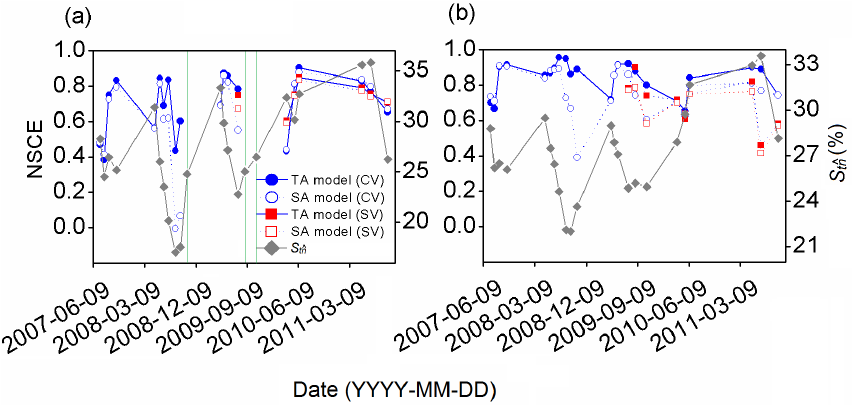
Figure 8. The Nash–Sutcliffe coefficient of efficiency (NSCE) of soil water content estimation using the TA and SA models for (a) 0–0.2 and (b) 0–1.0m for both cross-validation (CV) and split sample validation (SV). At 0–0.2m, three dates (22 October 2008, 27 August 2009, and 27 October 2009) as indicated by green lines present negative NSCE values ( − 4.05, − 1.83, and − 3.81, respectively, for the CV on the three dates; − 2.63 and − 5.12, respectively, for the SV on the latter two dates). Spatial mean soil water content S t ˆ n on each measurement day is also